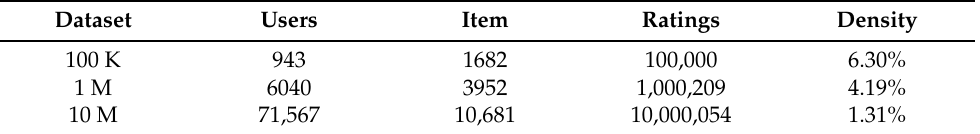
Table 1. Datasets of different